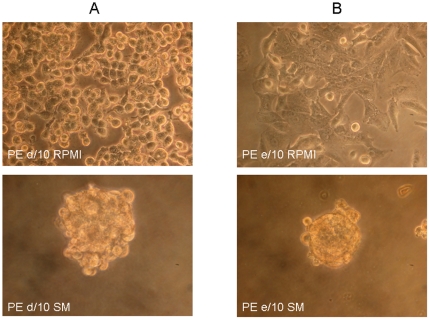
a: In the upper panel a sample picture of PE d/10 and PE e/10 cell culture grown in adherence in RPMI medium in presence of serum; b: in the lower panel the same primary cultures grown in non-adherent conditions supplemented with growth factors (bFGF and EGF) (200×).